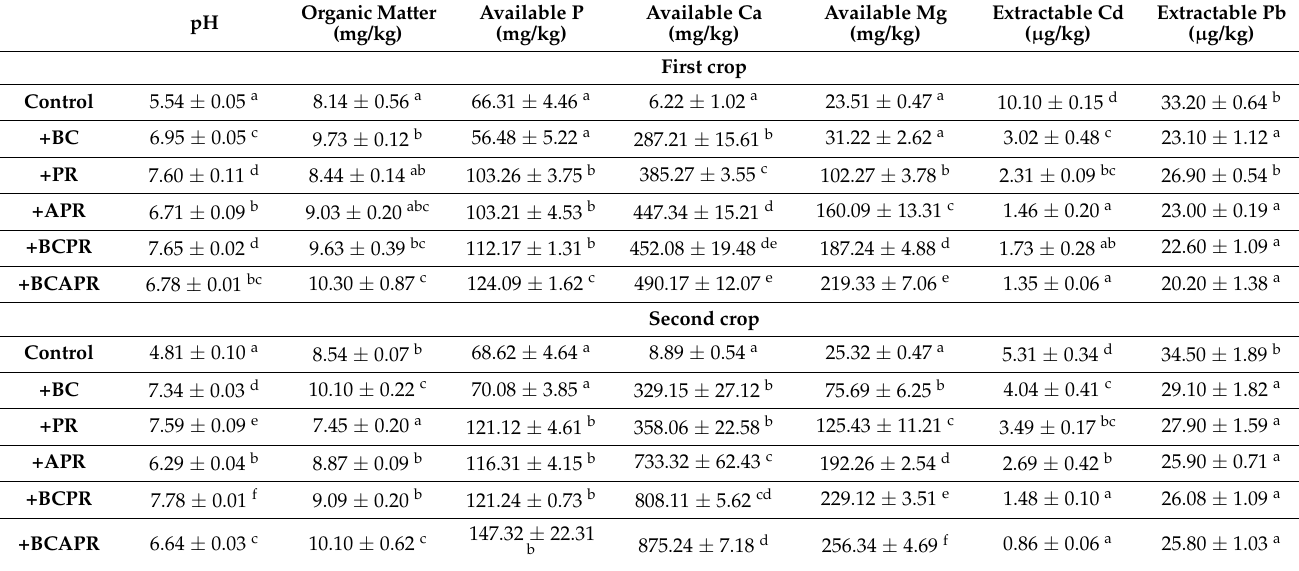
Table 1. Soil characteristics with different